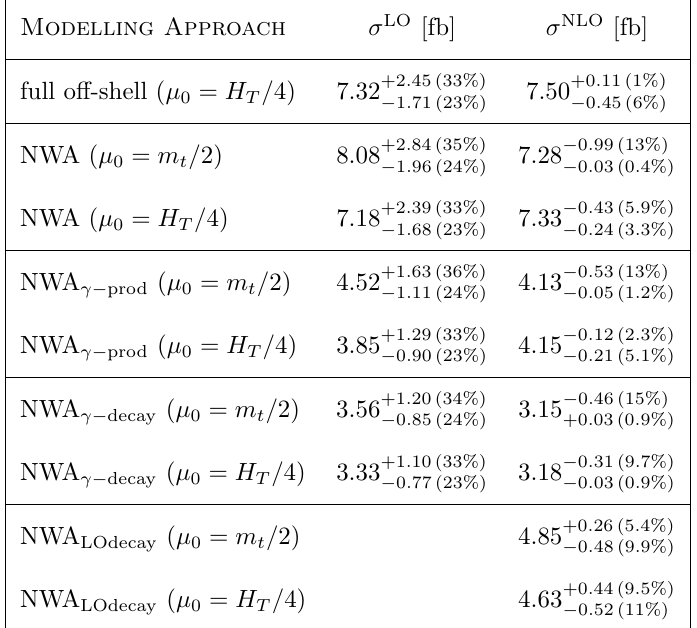
Table 2 . Integrated cross sections for the pp e + (cid:23) e (cid:22) (cid:0) (cid:22) (cid:23) (cid:22) b (cid:22) b(cid:13) + X production process at the LHC ! with p s = 13 TeV. Results for various approaches for the modelling of top quark decays are listed. Also given is the full o(cid:11)-shell result. We additionally provide theoretical uncertainties as obtained from the scale dependence. The CT14 PDF set is